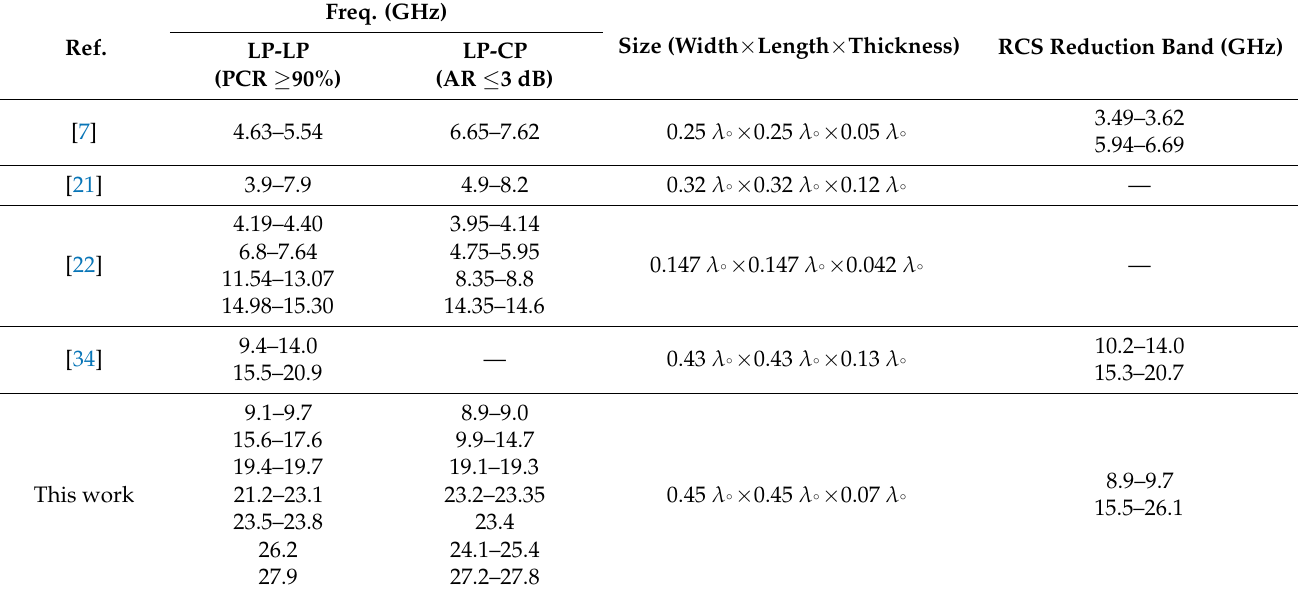
Table 1. Comparisons between this work and other